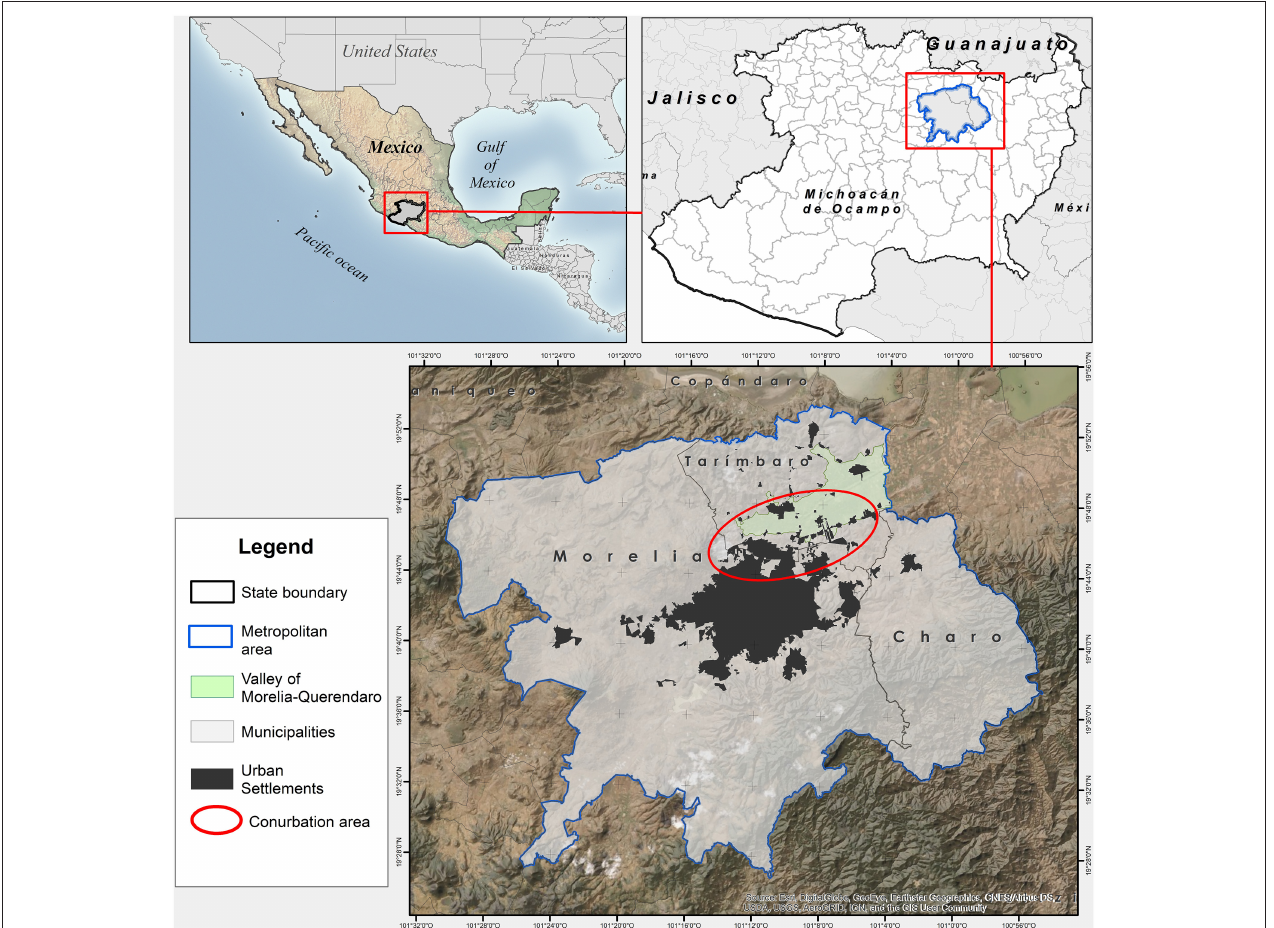
FIGURE 1 | Metropolitan zone of